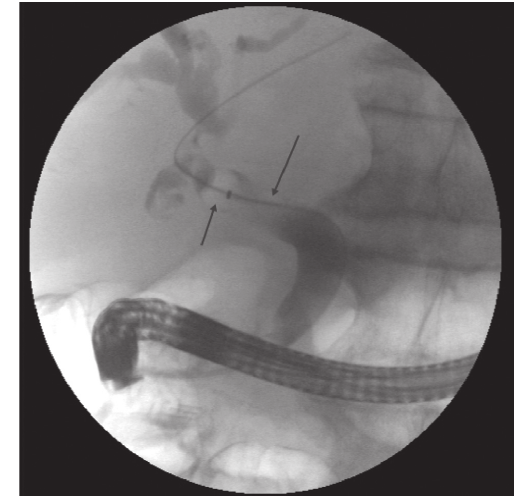
Figure 4: ERCP images demonstrate multiple filling defects (green arrows) within the common bile duct with moderate dilatation of the extra- and intrahepatic biliary tree. A complete sphincterotomy was performed, and multiple black pigmented stones were